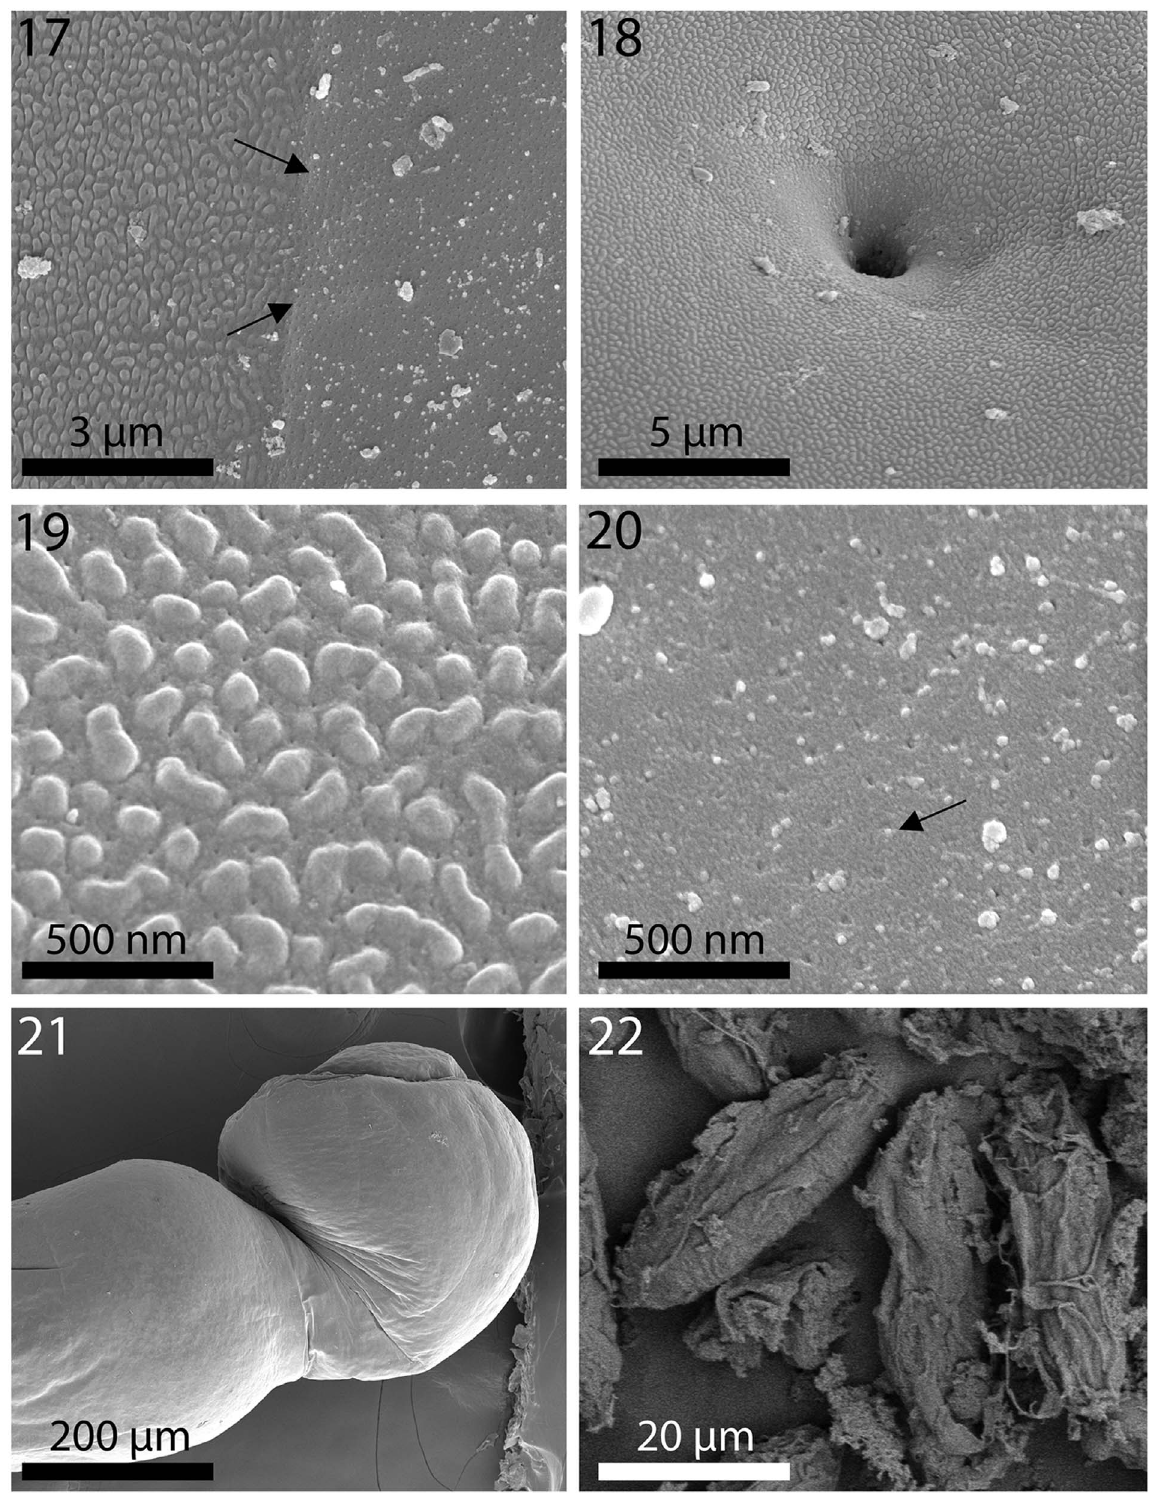
Figures 17 – 22. SEM of specimens of Neoechinorhynchus personatus from Mugil cephalus in the Mediterranean Sea off Tunisia. 17. The separation line (arrows) between the pebbled neck surface (left) and the anterior trunk with micropores of a specimen. 18. A sensory pore in the neck of a specimen showing the pebbled surface of the neck and the non-pebbled depression around the pore. 19. A magni fi ed view of the neck surface depressions. 20. Micropores (arrow) in the anterior trunk of a specimen. 21. The bursa of a male specimen showing no visible ornamentation or pores. 22.